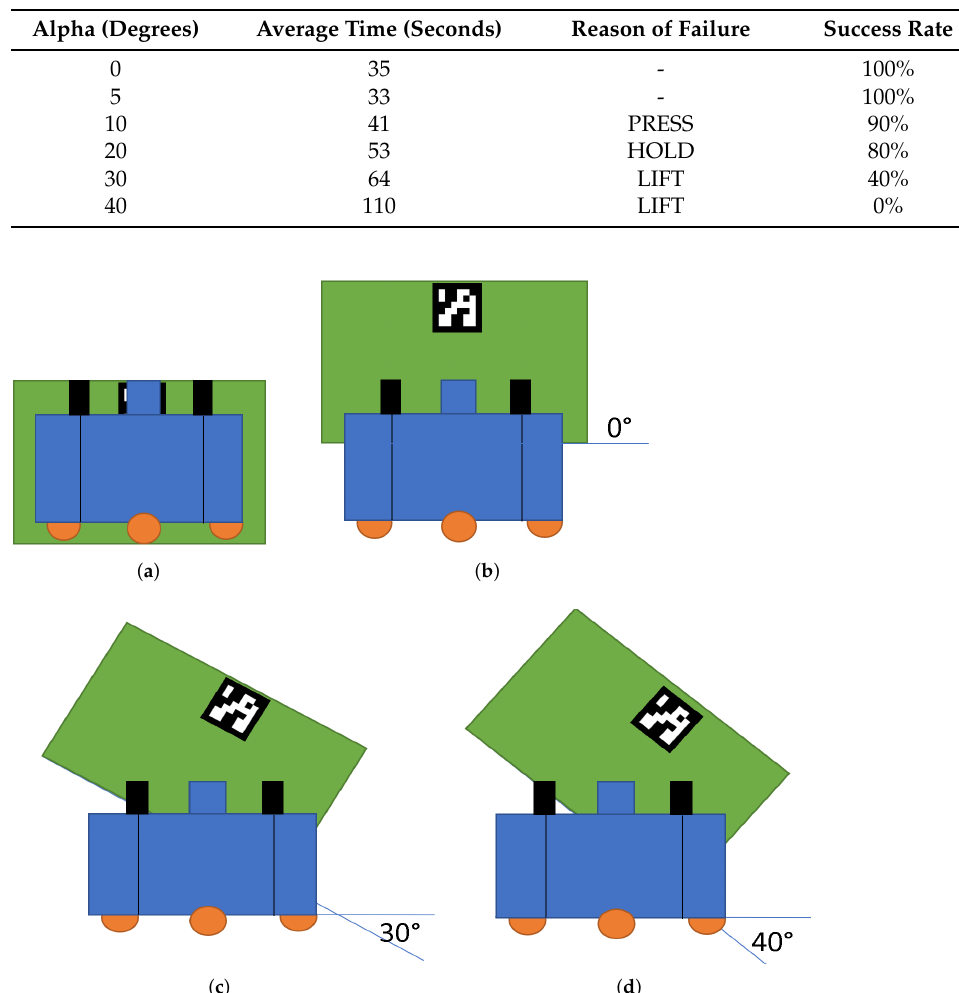
Table 1. Results of single robot approach and lift process changing angle alpha .